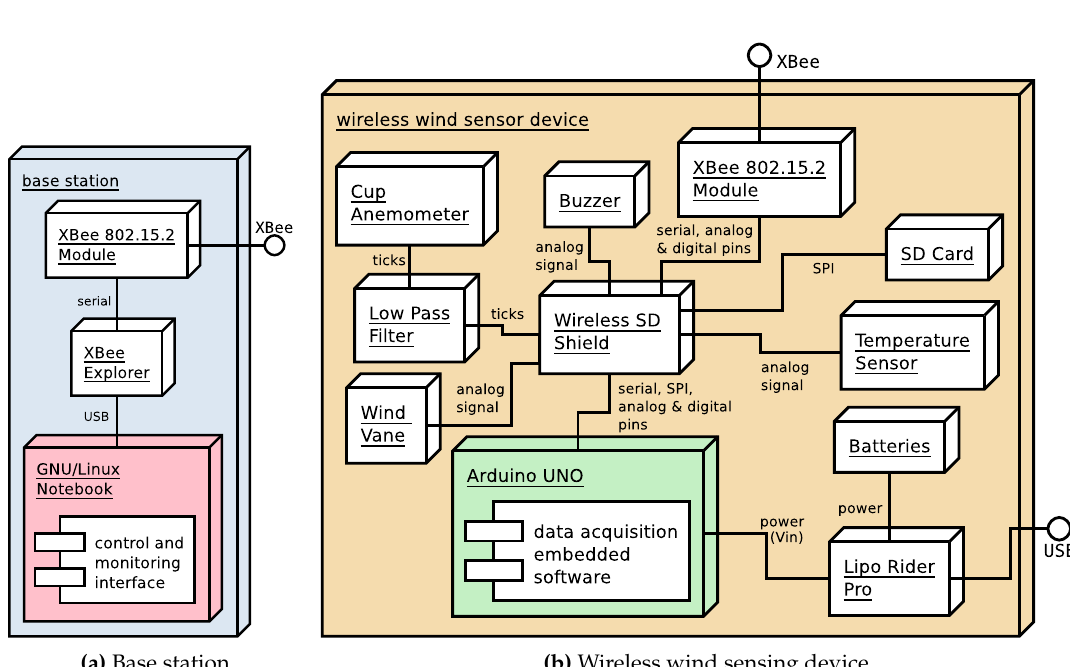
Figure 2. Wind data acquisition system. Deployment diagrams.